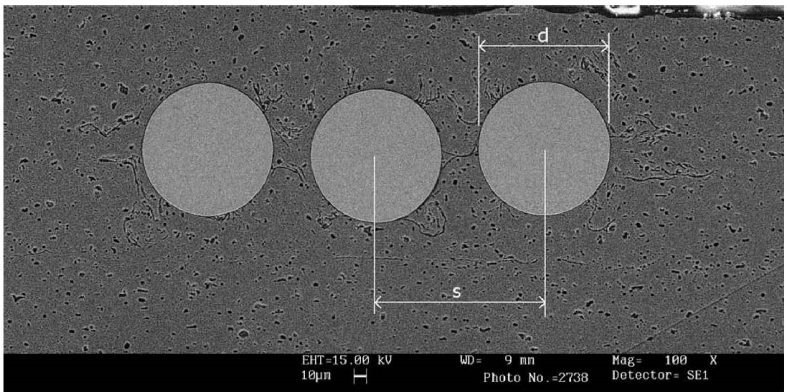
Figure 14. Scanning electron microscopy micrograph of SMA embedded specimen prepared at 27.8 mm/s weld speed, 10.4 μ m amplitude and 276 kPa contact pressure (Keller's etched)